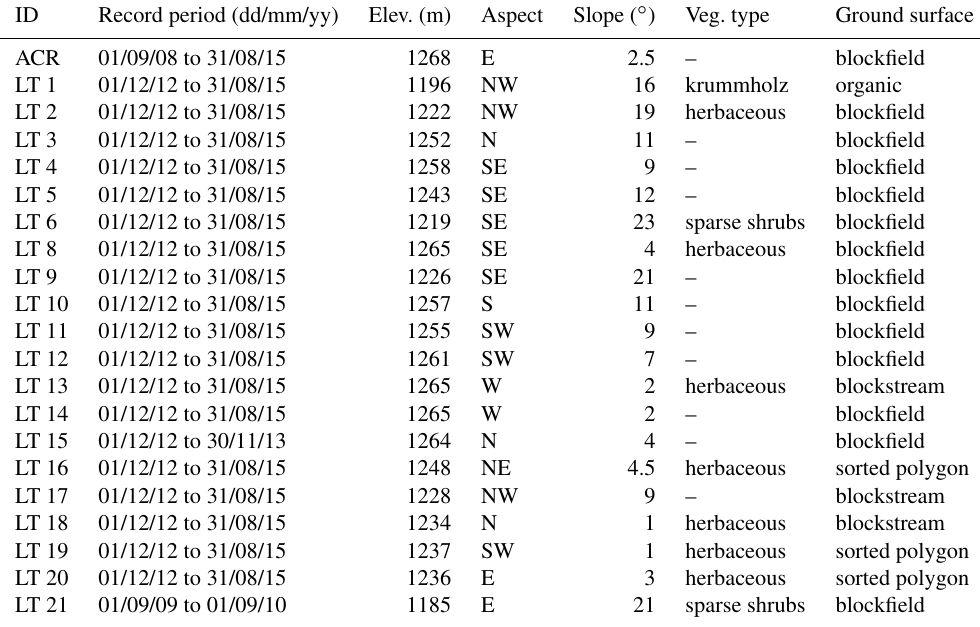
Table 2. Detailed information of sensors